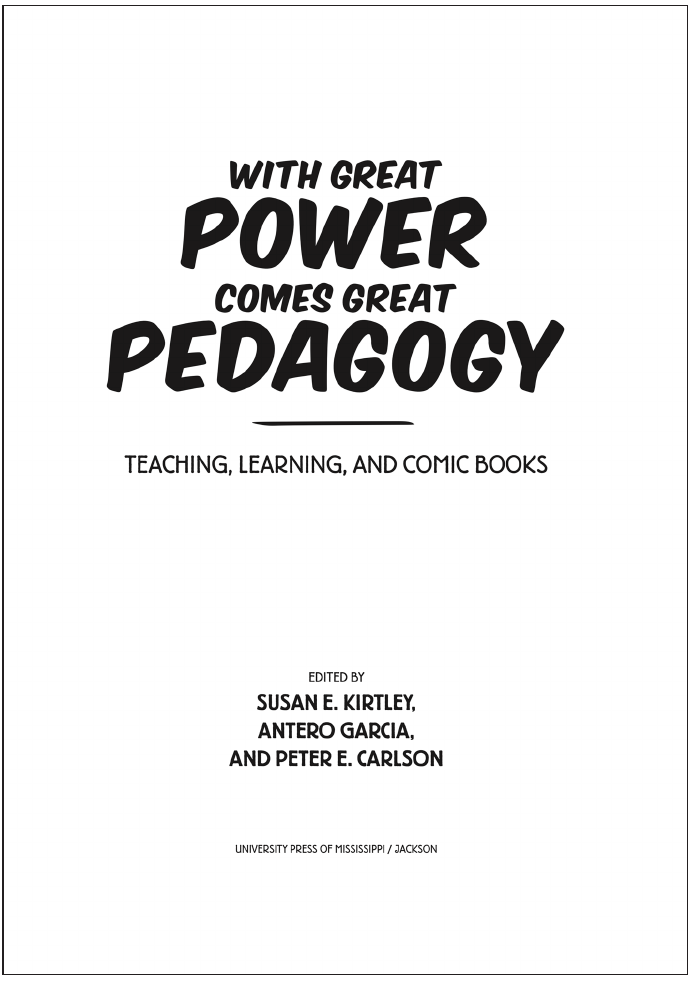
Figure 1: Inside cover of the advance review copy of With Great Power Comes Great Pedagogy: Teaching, Learning, and Comic Books , edited by Susan E. Kirtley, Antero Garcia, and Peter E. Carlson. Copyright © 2020 by University Press of